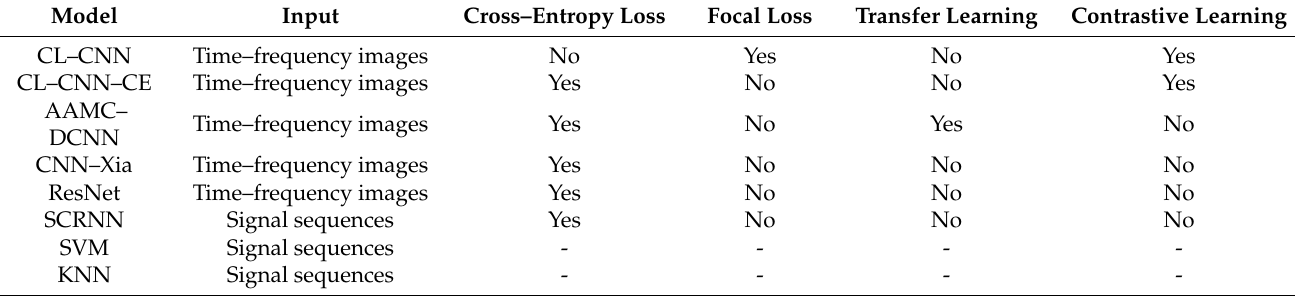
Table 3. The details of the deep models and traditional